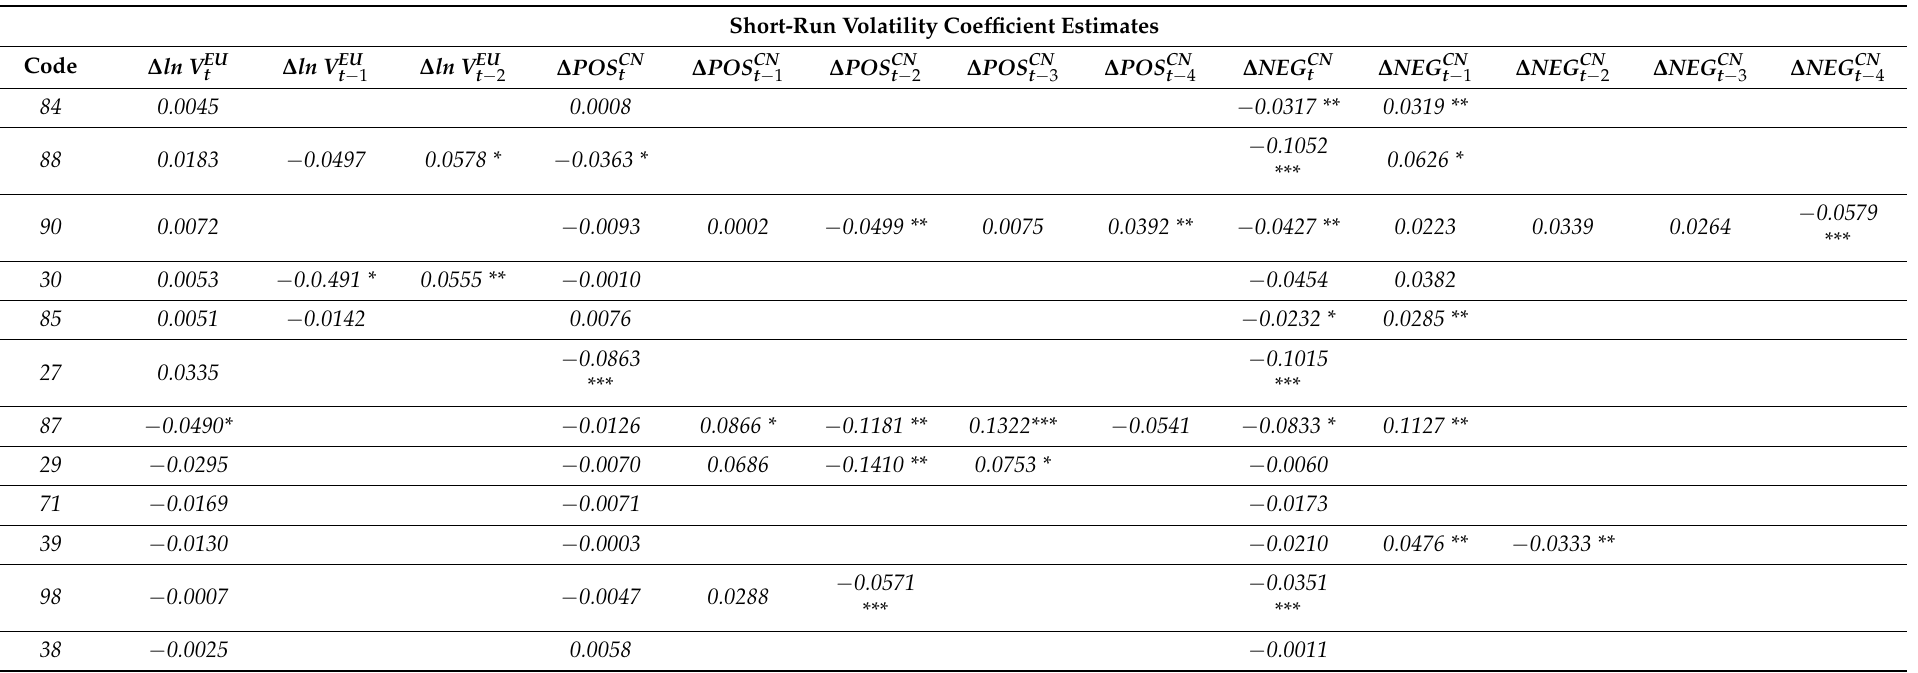
Table 7. Short-run coefficient estimates of volatility on US exports to the EU with third country effects using the nonlinear ARDL model (8). Short-Run Volatility Coefficient